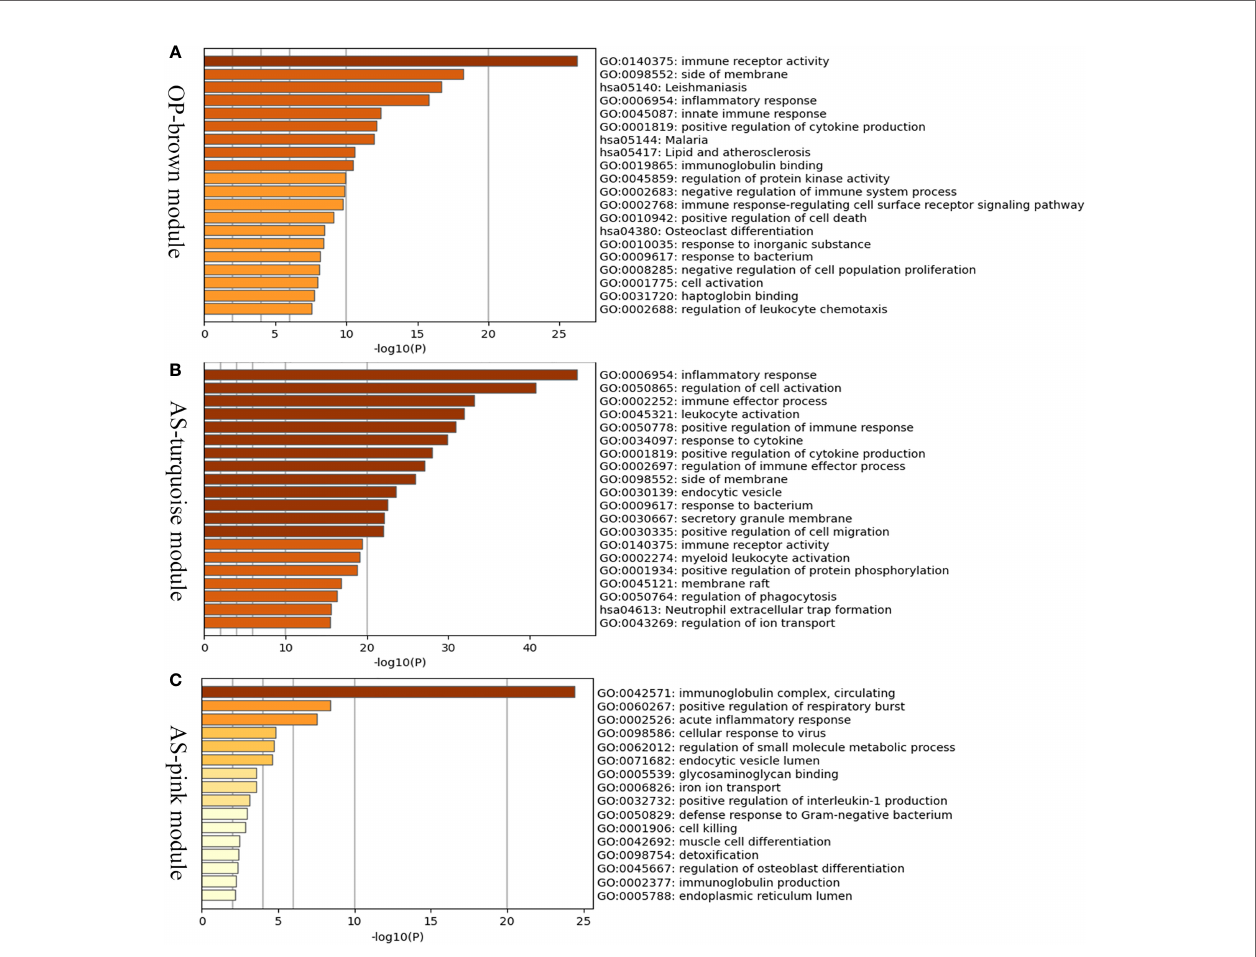
FIGURE 4 | Enrichment analysis of positive related modules in osteoporosis and atherosclerosis. (A) GO and KEGG enrichment analysis of MEbrown module in osteoporosis. (B) GO and KEGG enrichment analysis of MEturquoise module in atherosclerosis. (C) GO and KEGG enrichment analysis of MEpink module in atherosclerosis. OP, osteoporosis; AS,